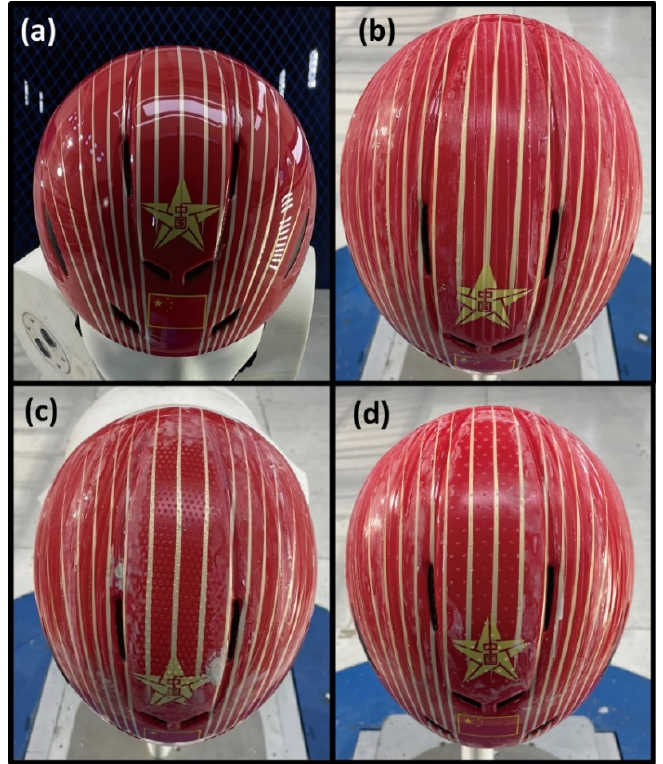
Figure 9. The helmets tested in the wind tunnel experiments. ( a ) is the original helmet; ( b ) is the type 1 helmet with all riblets; ( c , d ) are the type 2 and type 3 helmets with bumps at the middle region, respectively.